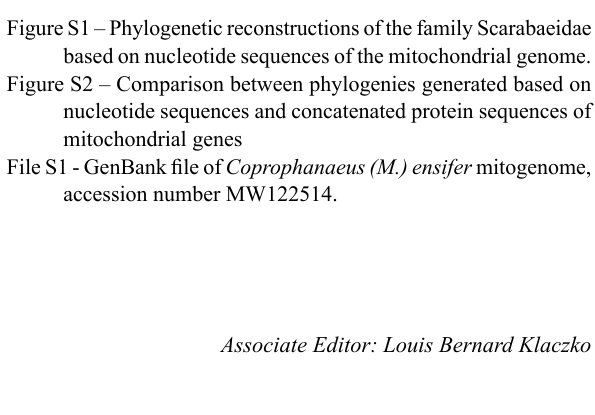
Figure S1 – Phylogenetic reconstructions of the family Scarabaeidae based on nucleotide sequences of the mitochondrial genome. Figure S2 – Comparison between phylogenies generated based